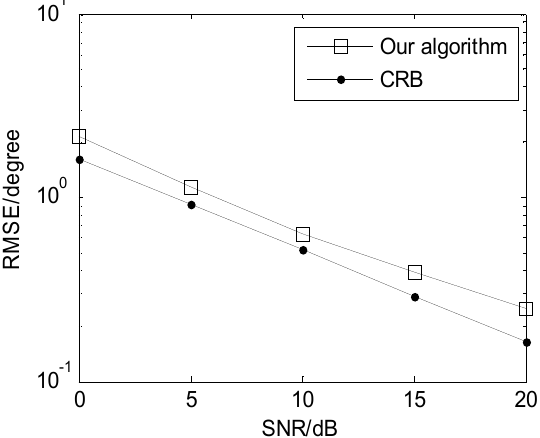
Figure 6. Angle estimation performance comparison ( M = 12, J = 100, and K =